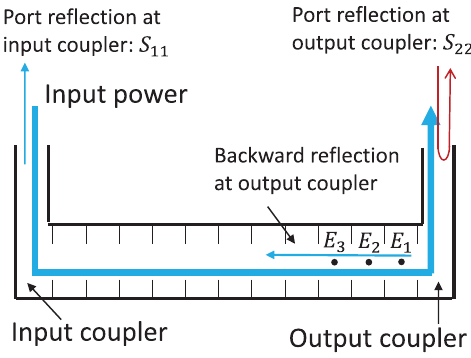
FIG. 14. Reflection in the output